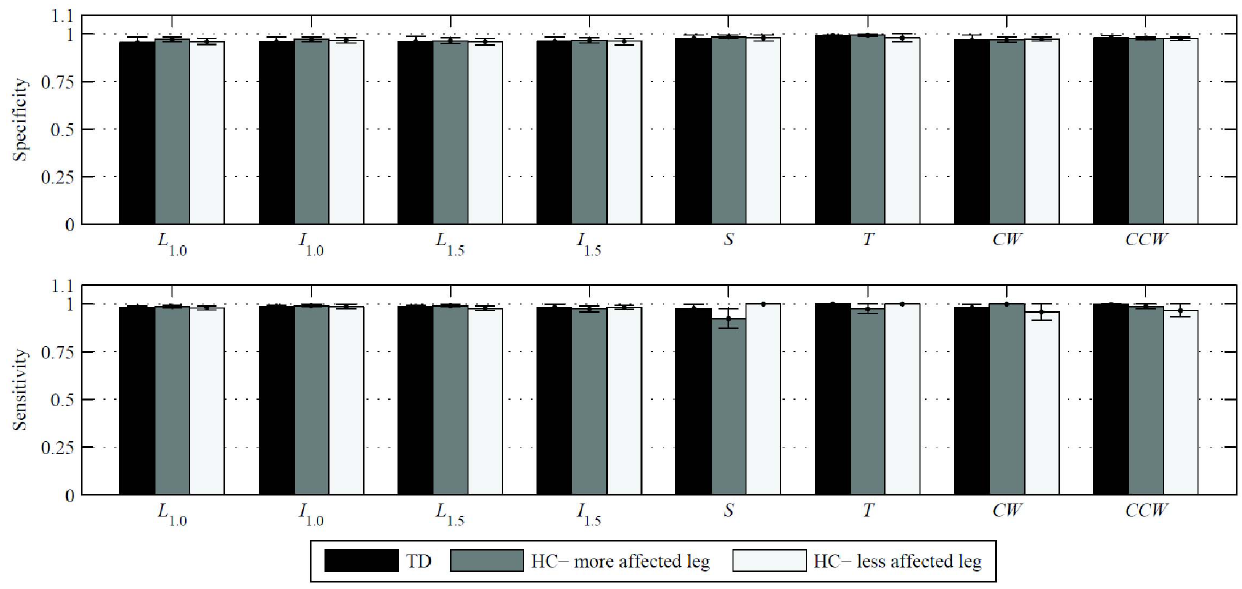
Figure 4. Specificity and sensitivity of A RT -detected gait phases, with A OL reference, for typically developing children and children with hemiplegia. The three populations are the combined legs of typically developing children (TD), the more affected legs of the children with hemiplegia (HC), and the less affected legs of the children with hemiplegia. Performance measures are given as mean 6 one standard error over each population. For patients with equally affected sides, the right is taken as the more affected